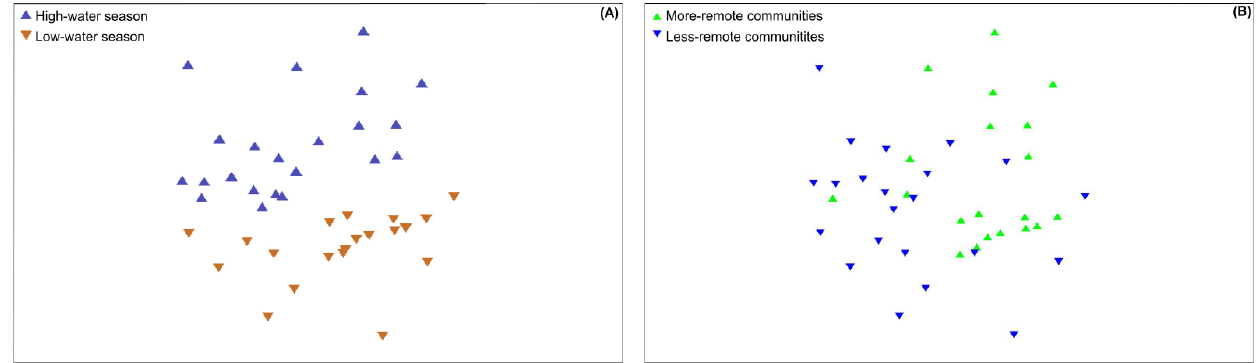
FIGURE 3 | Fish assemblages vary markedly by ( A ) hydrological season and ( B ) geographical remoteness, shown by NMDS (Non-metric Multidimensional Scaling) graphs. Based on similarity analysis of seasonal fish assemblages. Less-remote communities are those < 600 km fluvial travel distance from Manaus, which receive visits by Manaus-based boats that purchase fish and deposit ice at least weekly, while more-remote communities are those > 600 km fluvial travel distance from Manaus that do